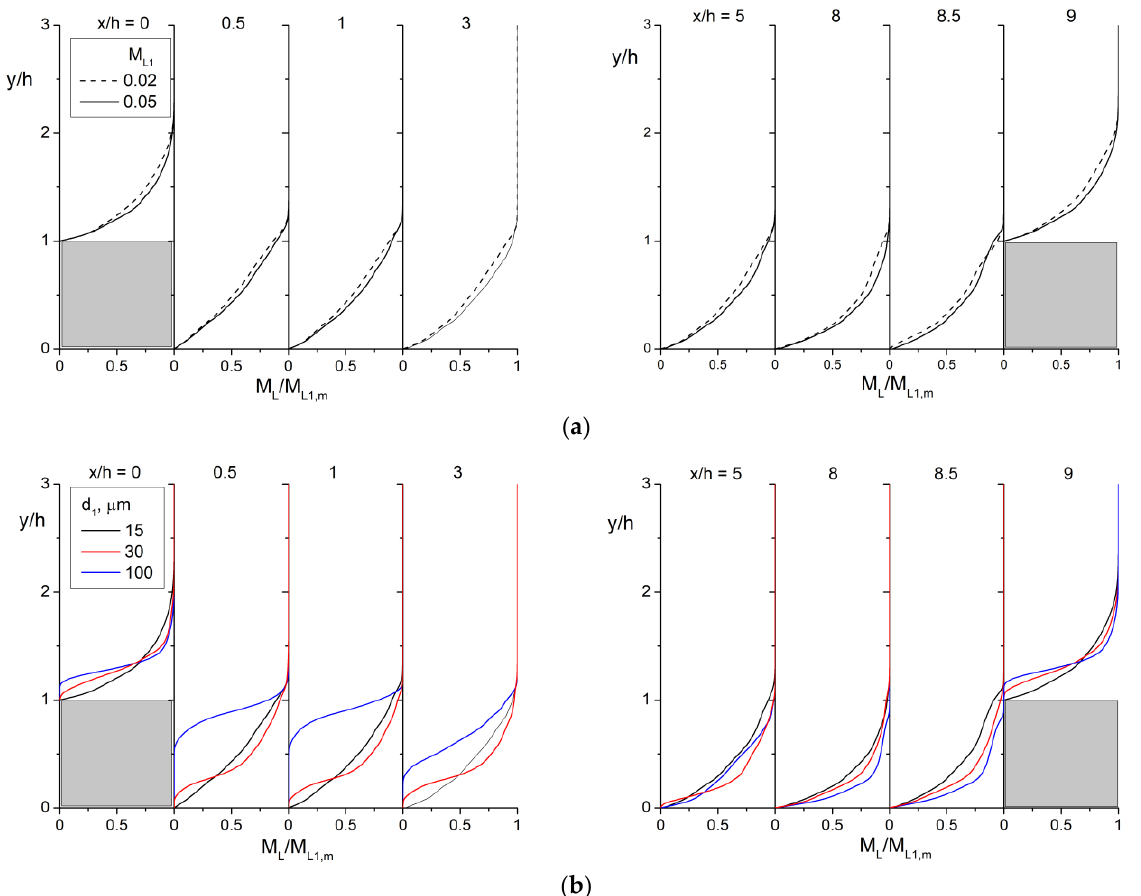
Figure 8. Transverse profiles of the water droplet mass fraction vs. the initial mass fraction ( a ) and the droplet diameter ( b ). Re = 1.6 × 10 4 . ( a ) d 1 = 15 μm ; ( b ) M L 1 = 0.05. the droplet diameter ( b ). Re = 1.6 × 10 4 . ( a ) d 1 = 15 µ m; ( b ) M L 1 =